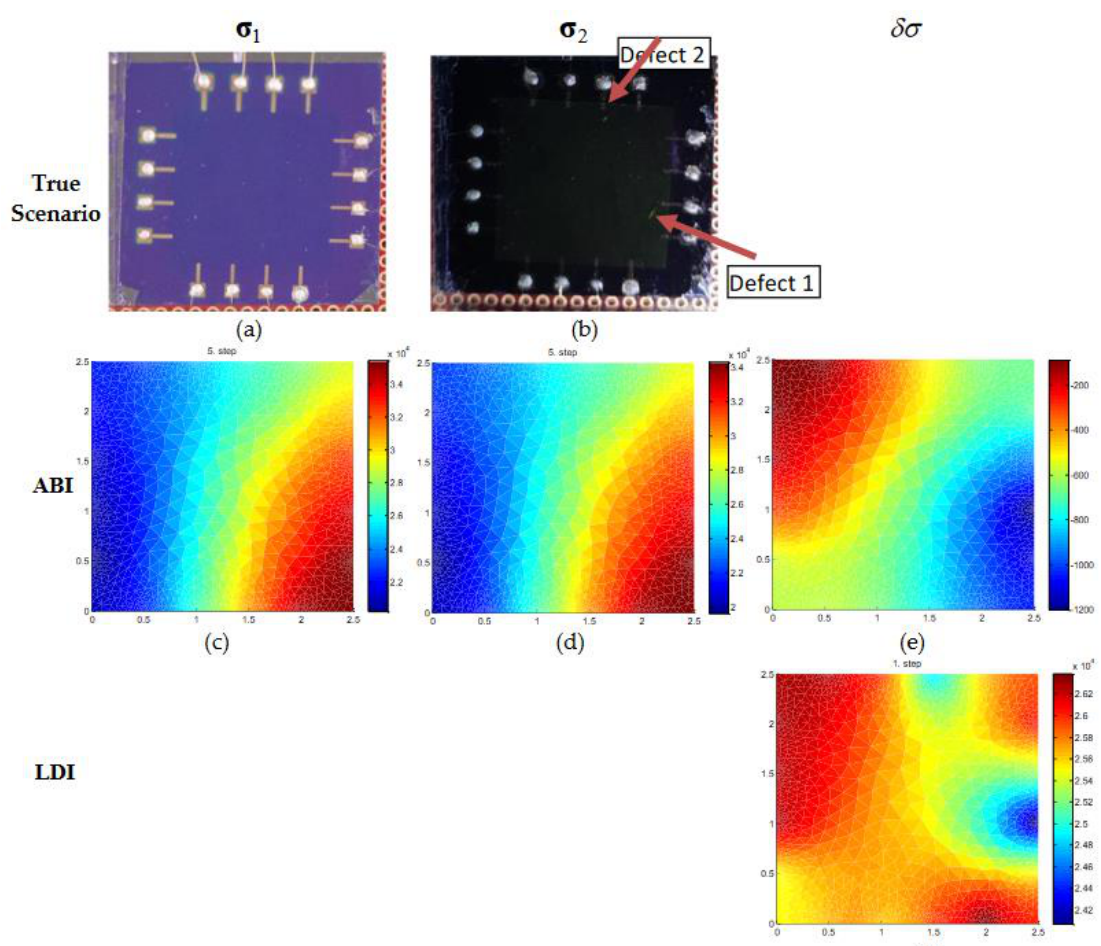
Figure 8. Conductivity estimation of real graphene wafer of size 2.5 × 2.5 cm. ( a , b ) The top row is the true condition of the real graphene sheet without defects and with two defects used during the experiment. ( c – e ) The second row, ( f ) third rows are the estimated conductivities of initial ( σ ) , final distribution ( σ ) , and conductivity change ( δσ ) using ABI and distribution 2 1